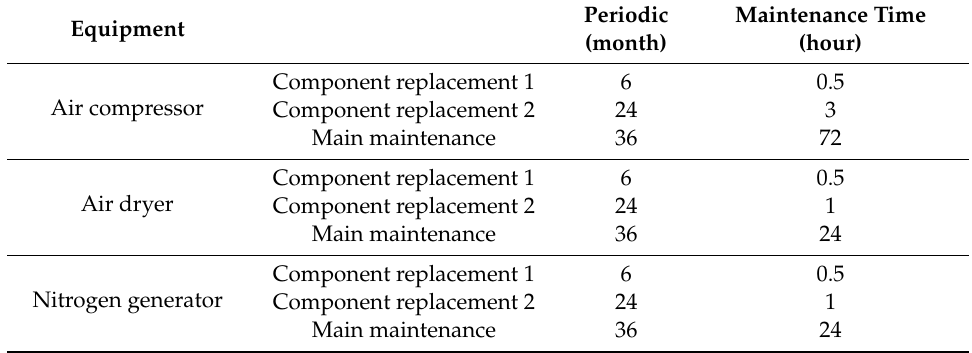
Table 3. Preventive maintenance information on air compression and nitrogen generation